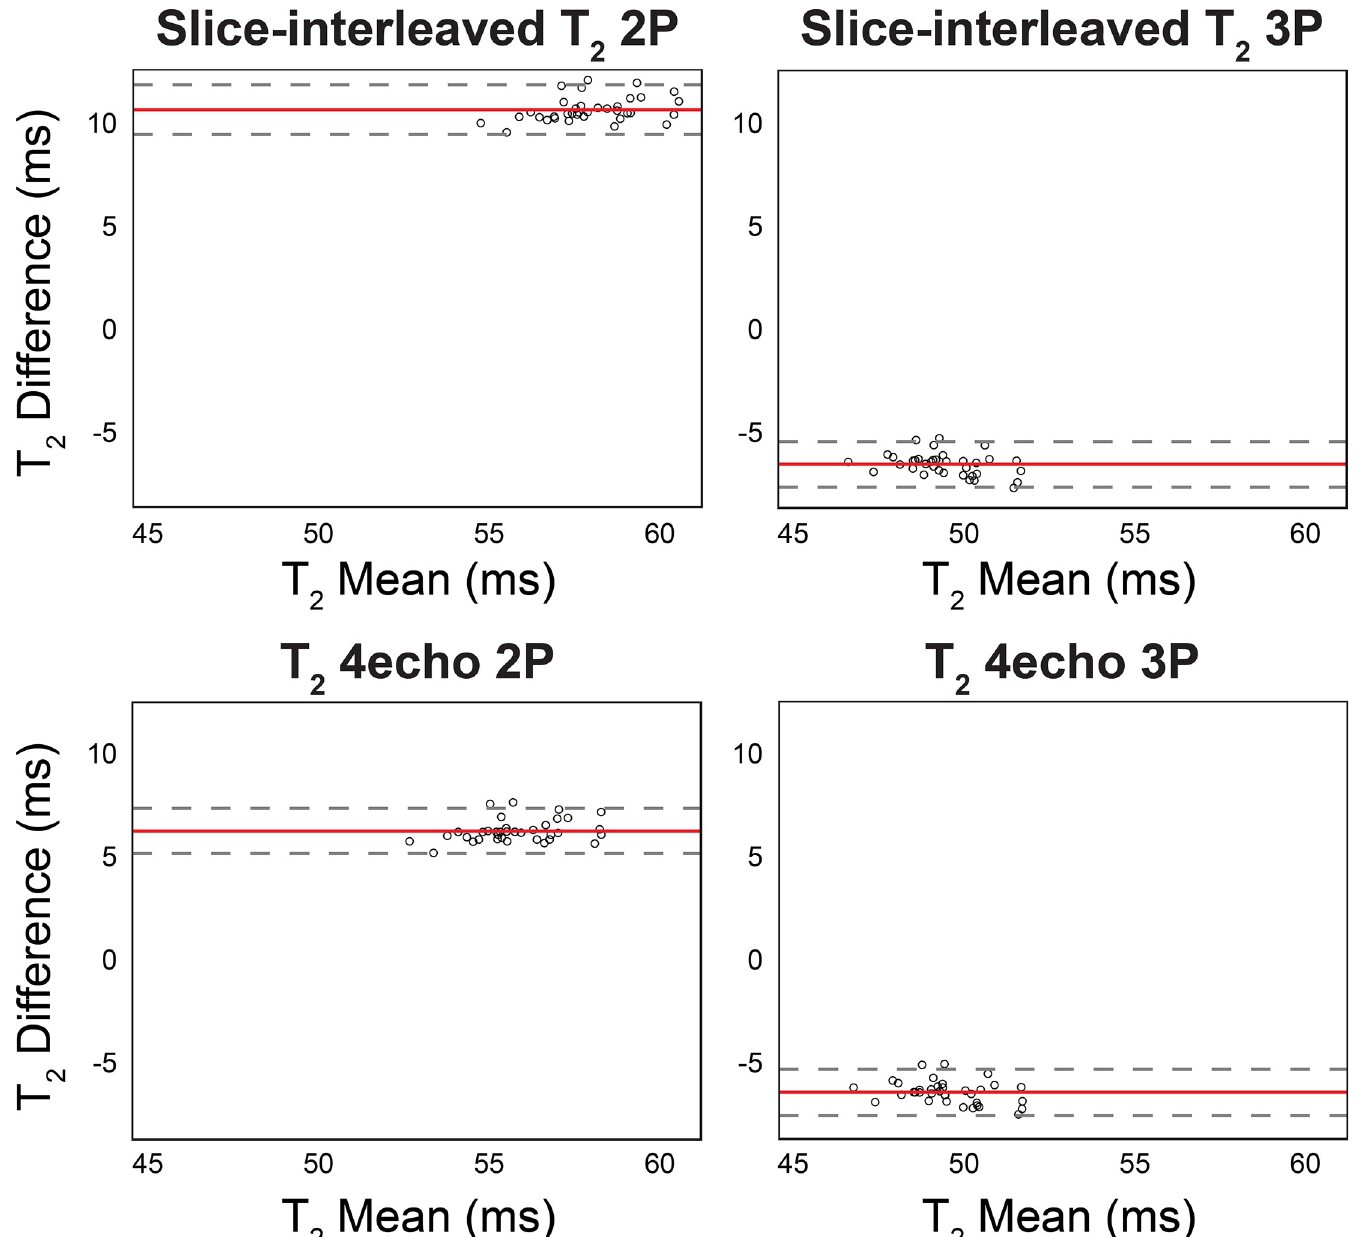
Fig 6. Bland-Altman plots of slice-interleaved T 2 mapping sequences against the reference SE T 2 measurements. Bland-Altman analyses of slice-interleaved T 2 mapping shows an overestimation when the map is reconstructed with a 2-parameter fit model, and an underestimation when reconstructed with a 3-parameter fit model. Each data point represents one study time point which was averaged for all repetitions and slices within session. The mean difference (bias) is presented as the red line, and the 95% limits of agreement (mean ± 2 standard deviations) are presented as dashed lines.